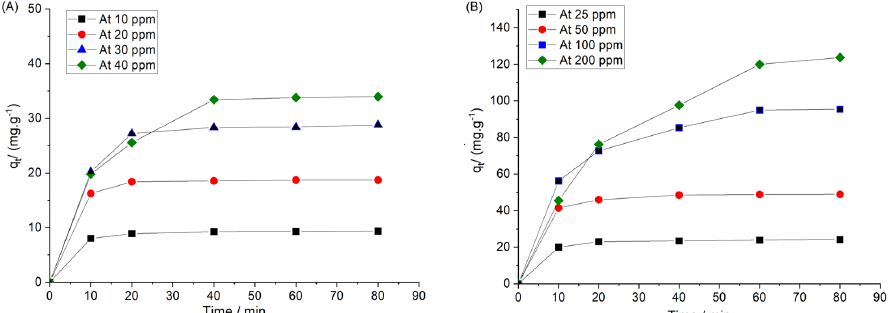
Figure 9. Adsorption of the selected dyes as a function of time at different initial concentrations and 298 K: ( A ) adsorption of Fl, and ( B ) adsorption of CV.